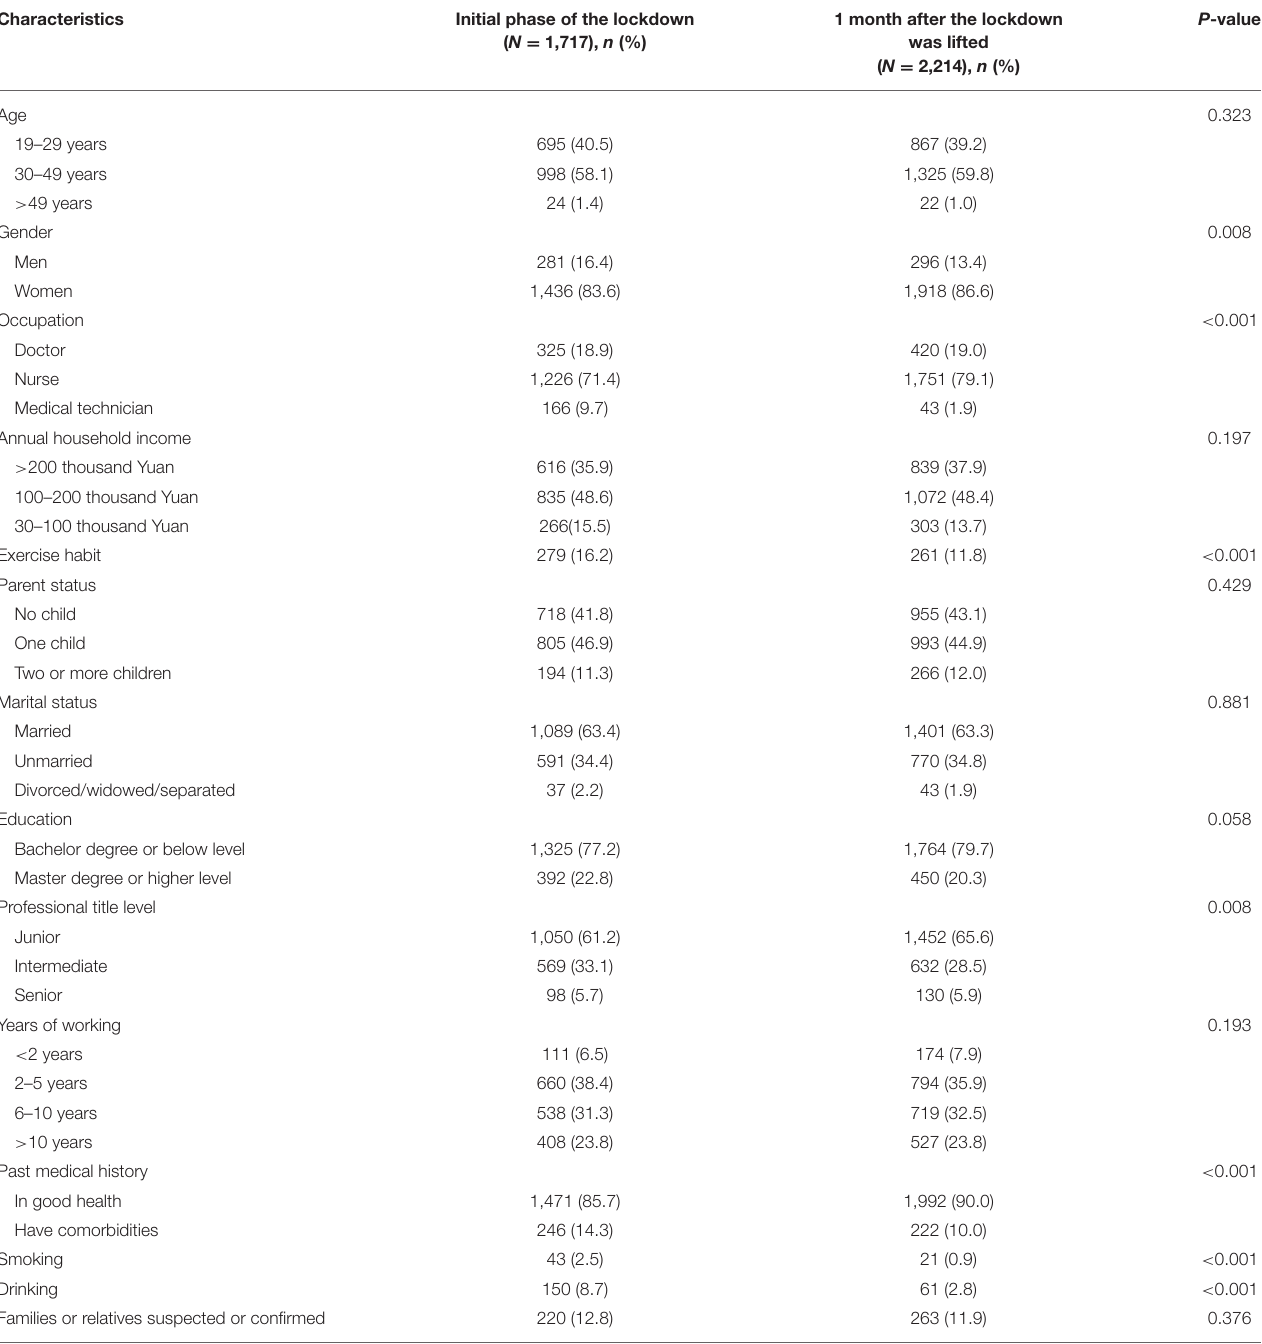
TABLE 1 | Sociodemographic characteristics of front-line health workers dealing with the COVID-19 in two phases.